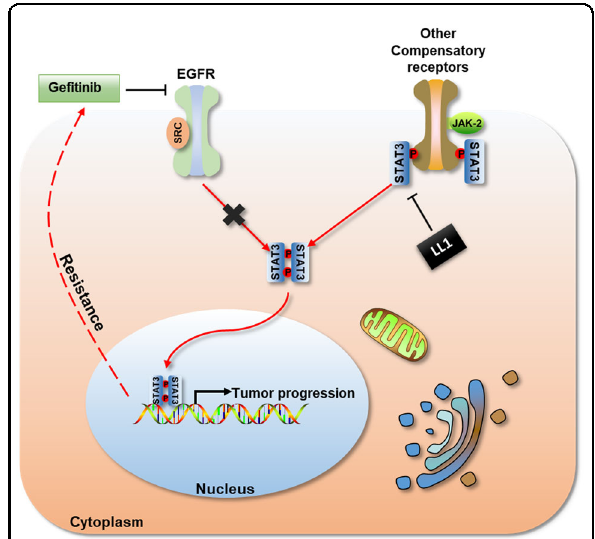
Fig. 7 Schematic diagram of STAT3 in ge fi tinib resistance. When ge fi tinib resistance occurs, the cancer cells would try to break through the EGFR/STAT3 signaling pathway. Due to the persistent inhibition of EGFR by ge fi tinib, they had to compensatively activate other signaling pathways which pass through STAT3. Blocking STAT3 activation by LL1 can reactivate the ef fi cacy of ge fi